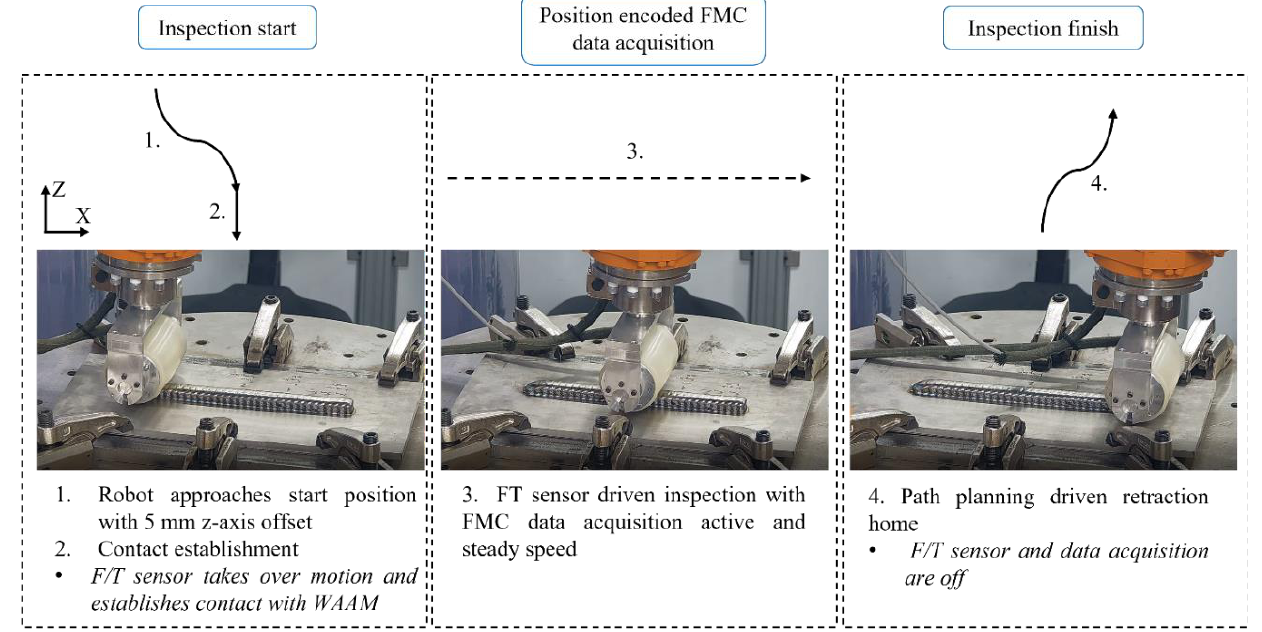
Figure 8. Inspection diagram showing the process and the sequence of robotic motions during an inspection.